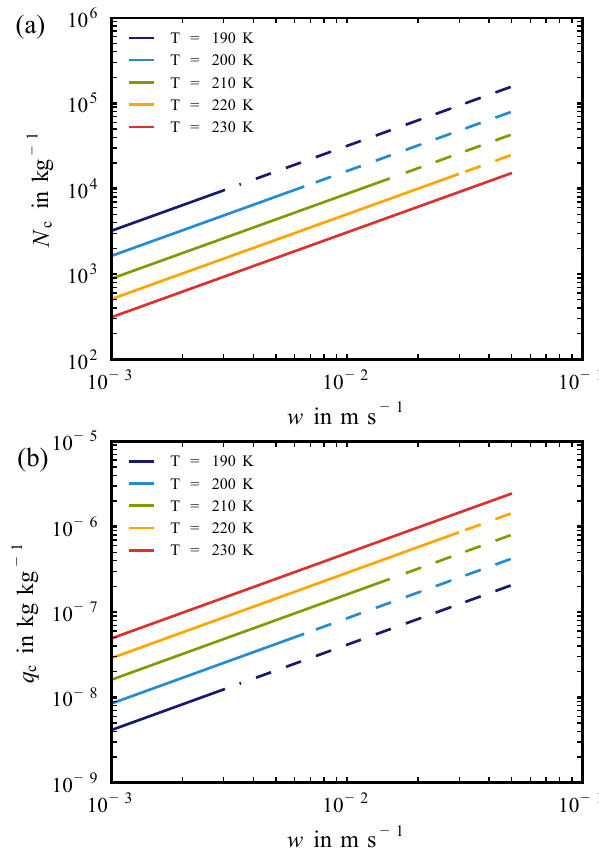
Figure 8. Ice particle number concentration N c (upper panel) and ice particle mass concentration q c (lower panel) at the equilibrium state x 0 as a function of vertical velocity for different temperatures. Solid lines indicate parameter combinations ( w , T ) in the stable focus regime (state 1); dashed lines represent the limit cycle regime (state 2), i.e. at the unstable focus x 0 .